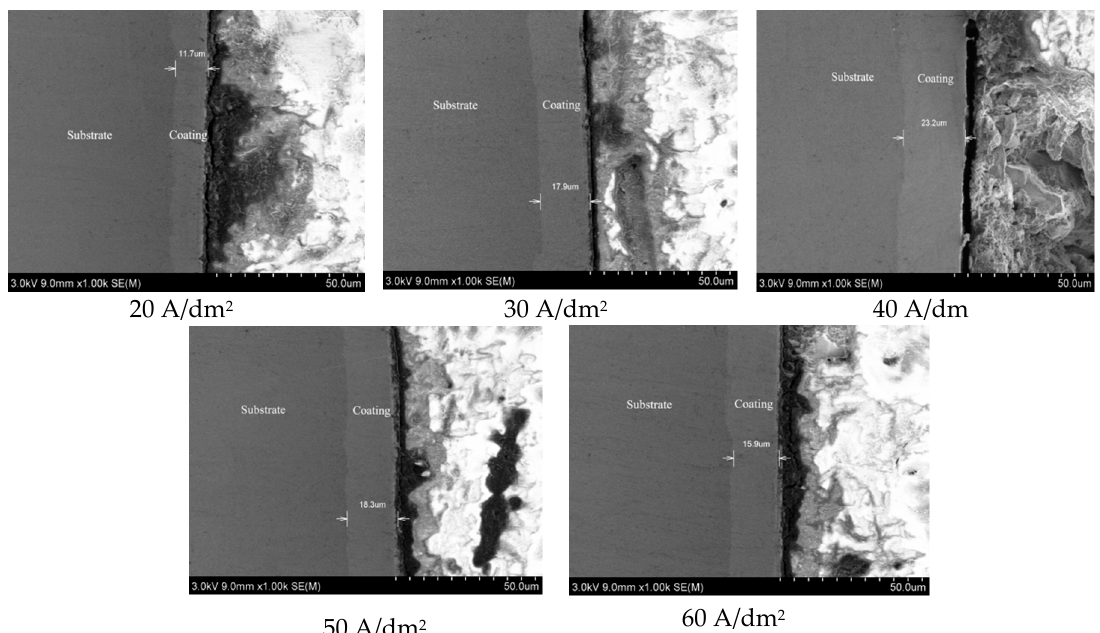
Figure 3. Cross-sectional micromorphologies of Ni–P–ZrO 2 –CeO 2 composite coatings prepared at different current densities.